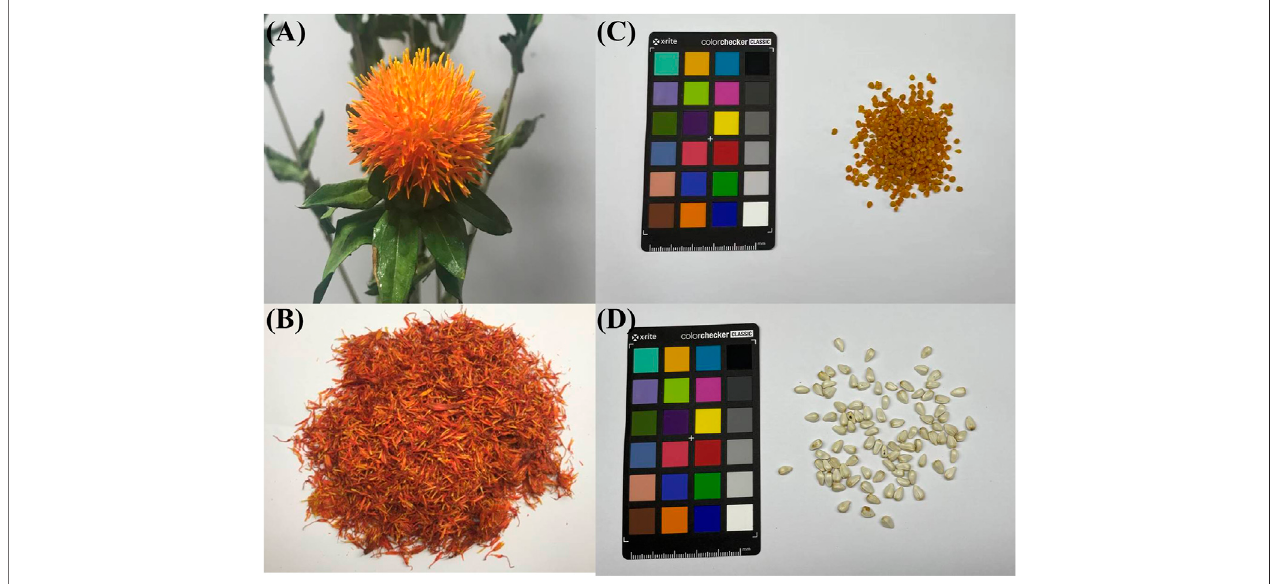
FIGURE 1 | The fl ower, bee pollen and seeds of saf fl ower [ (A) : fresh fl ower, (B) : dried fl ower, (C) : bee pollen, (D) : seeds).